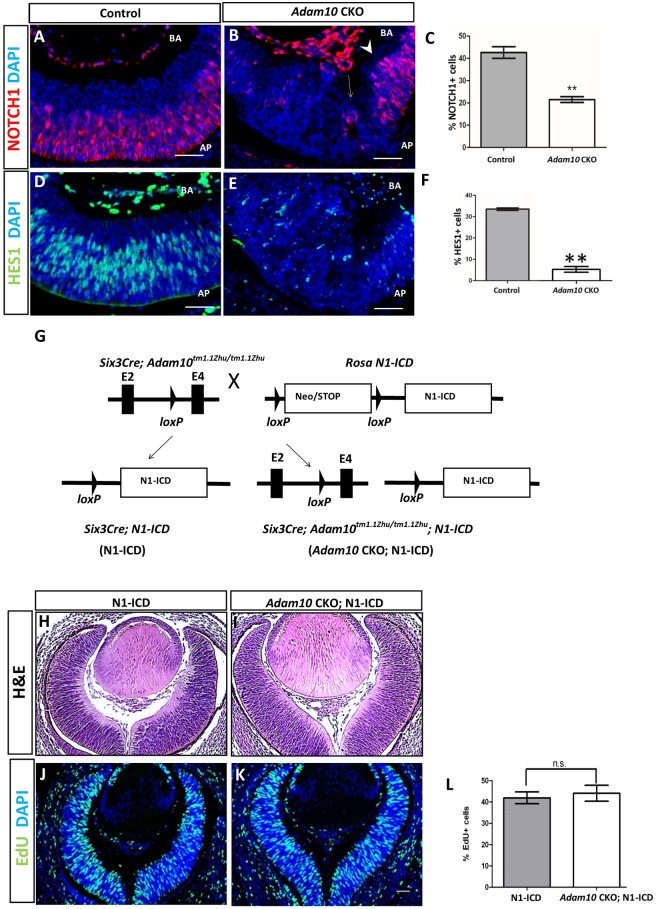
Overexpression of N1-ICD in Adam10 CKO retinae rescues aberrant retinal morphogenesis and neurogenesis.In controls (A) NOTCH1-positive cells were restricted to the neuroblastic layer. In Adam10 CKO retinae, within the central retinae only a very few NOTCH1-positive cells were identified associated with rosettes (B, arrow) although towards the retinal periphery NOTCH1-positive cells were identified restricted to the neuroblastic layer (B, arrowhead). Quantification analysis (C) identified in controls 42 ± 1.2% (gray bar) and in Adam10 CKO 22.79 ± 0.11% (white bar) NOTCH1-positive cells indicating a significantly fewer (**P = 0.001; n = 3) percentage of NOTCH1-positive cells in Adam10 CKO retinae when compared to the controls. In controls HES1, immunostaining was restricted to the neuroblastic layer (D) whereas in Adam10 CKO retinae a very few HES1-positive cells were identified within the central retinae and HES1-positve cells appeared disorganized (E). Quantification analysis (F) identified in controls 34 ± 0.01% (gray bar) and in Adam10 CKO retinae 4.7 ± 0.2% (white bar) HES1-positive cells indicating a significantly fewer (**P = 0.0004; n = 3) percentage of HES1-positive cells in Adam10 CKO retinae when compared to controls. (G) Adam10 CKO mice were crossed to RosaN1-IC (N1-ICD) mice harboring a Neo/STOP cassette flanked by loxP sites upstream of a sequence encoding the intracellular domain of the NOTCH1 gene thereby generating Adam10 CKO; N1-ICD mice that exhibit constitutive expression of N1-ICD in the same retinal cells in which Six3-CRE led to ablation of Adam10. H&E staining revealed in N1-ICD mice (H) and Adam10 CKO;N1-IC mice (I) highly organized retinae. In N1-ICD retinae (J) and Adam10 CKO;N1-IC retinae (K) EdU-positive cells were present in all retinal layers. Quantification analysis (L) revealed in N1-ICD retinae 41.99 ± 2.78% (gray bar) and in Adam10 CKO retinae 44.15 ± 3.76% (white bar) EdU-positive cells indicating that the percentage of EdU positive retinal cells did not significantly differ (P = 0.24; n = 3). Bars in (C), (F), and (L) represent mean values ± SEM. Significance was established with the Student’s t-test and P<0.05 was considered significant. AP = apical surface. BA = basal surface. Scale bars = 50 μm.